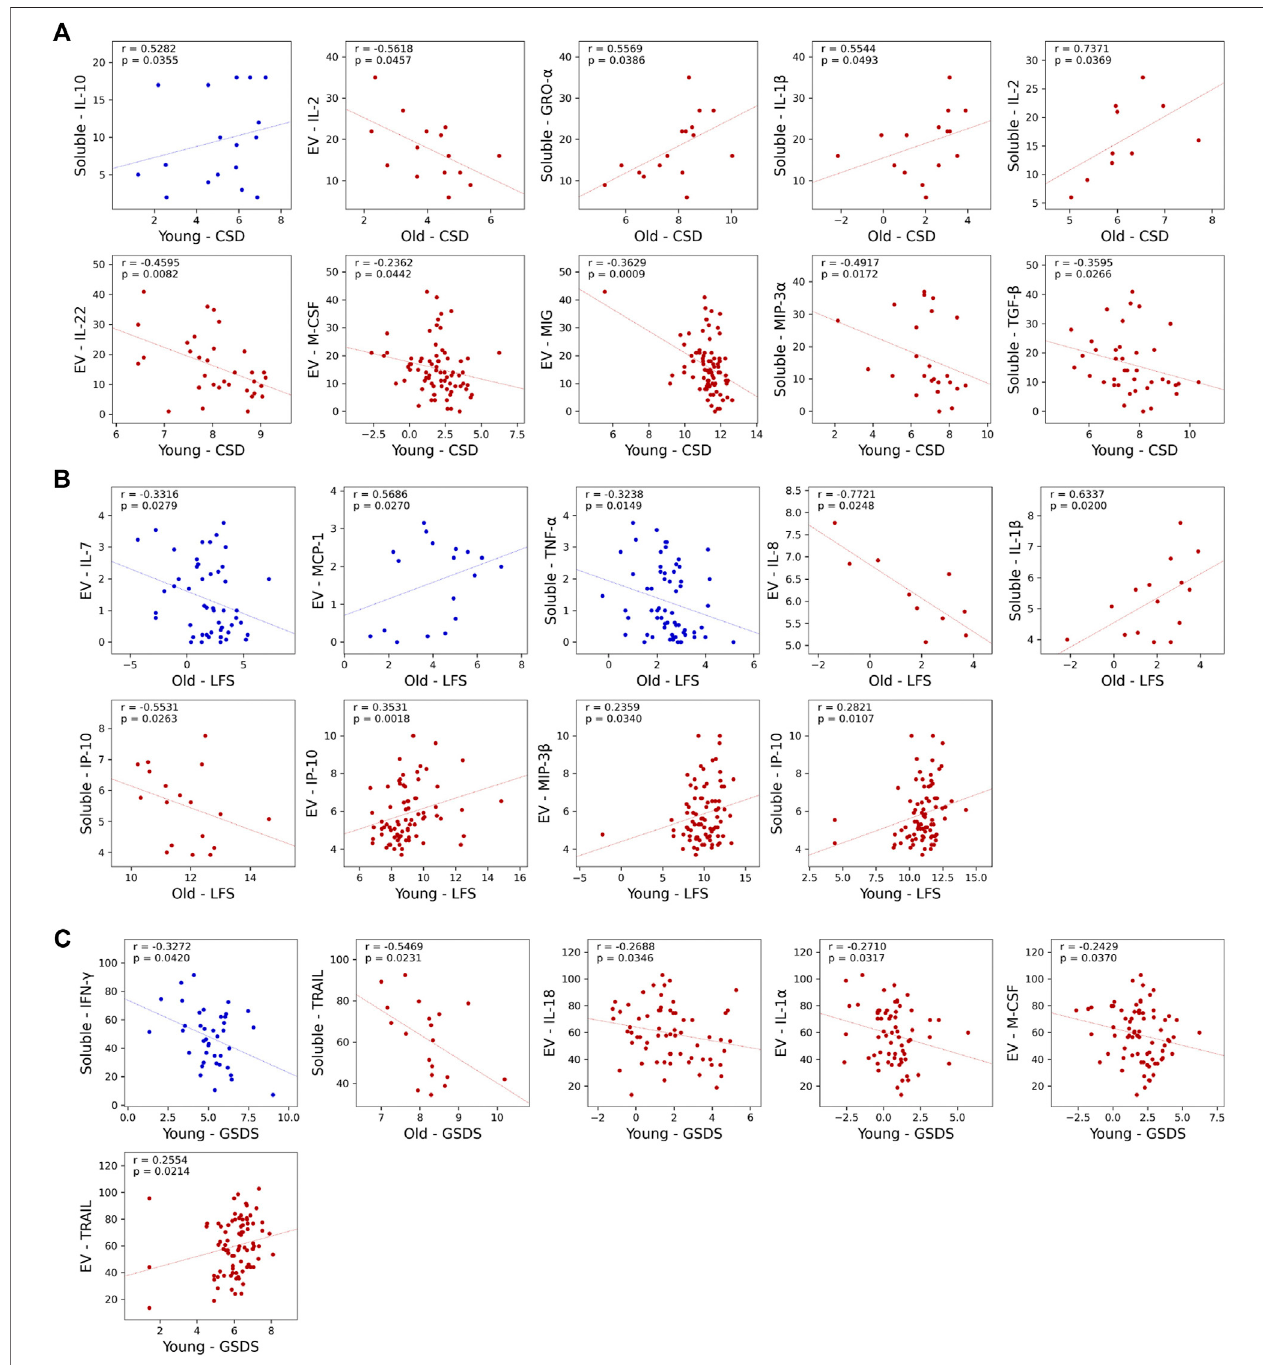
FIGURE 3 | Scatterplots showing statistically signi fi cant partial correlations between measured cytokine concentrations and three of the symptoms at enrollment: Center for Epidemiologic Studies-Depression Scale (CES-D) (A) , Lee Fatigue Scale (LFS) (B) , and General Sleep Disturbance Scale (GSDS) (C) . Partial correlations are calculated using Spearman correlation, with Karnofsky Performance Status (KPS) scale used as a covariate in the younger cohort and both KPS and body mass index (BMI)usedasacovariateintheoldercohort.Cytokineconcentrationsoutsideofthedetectionrangewereexcludedfromanalysis,asweregroupswith n < 10.Data from High Fatigue/Low Pain classes are shown in red and data from All Low classes are shown in blue. Abbreviations: α = alpha, β = beta , CES-D = Center for Epidemiological Studies-Depression Scale, EV =extracellular vesicle, GSDS = GeneralSleep DisturbanceScale, GRO- α =growth-regulated alpha, IFN- γ =interferon- γ , IL= interleukin, IP-10 = interferon- γ -induced protein, LFS= Lee Fatigue Scale, MCP-1 = monocyte chemoattractant protein-1, MIP = macrophage in fl ammatory protein, M-CSF=macrophagecolony-stimulatingfactor,MIG=monokineinducedbyIFN- γ ,TGF- β =transforminggrowthfactorbeta,TNF- α =tumornecrosisfactor- α ,TRAIL= TNF- related apoptosis-inducing